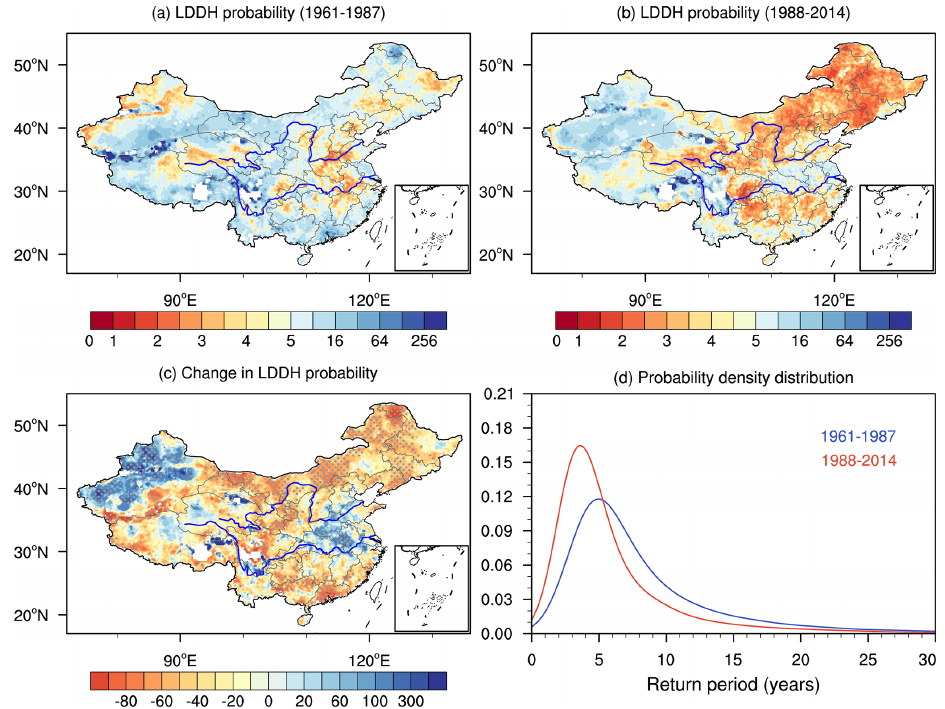
Figure 4. Return periods (years) of compound long-duration dry and hot events for (a) 1961–1987 and (b) 1988–2014. (c) Percentage changes (%) across the study area for 1988–2014 relative to 1961–1987. Stippling indicates locations with significant changes at the 90% confidence interval. (d) Probability density functions based on all grid points for the two